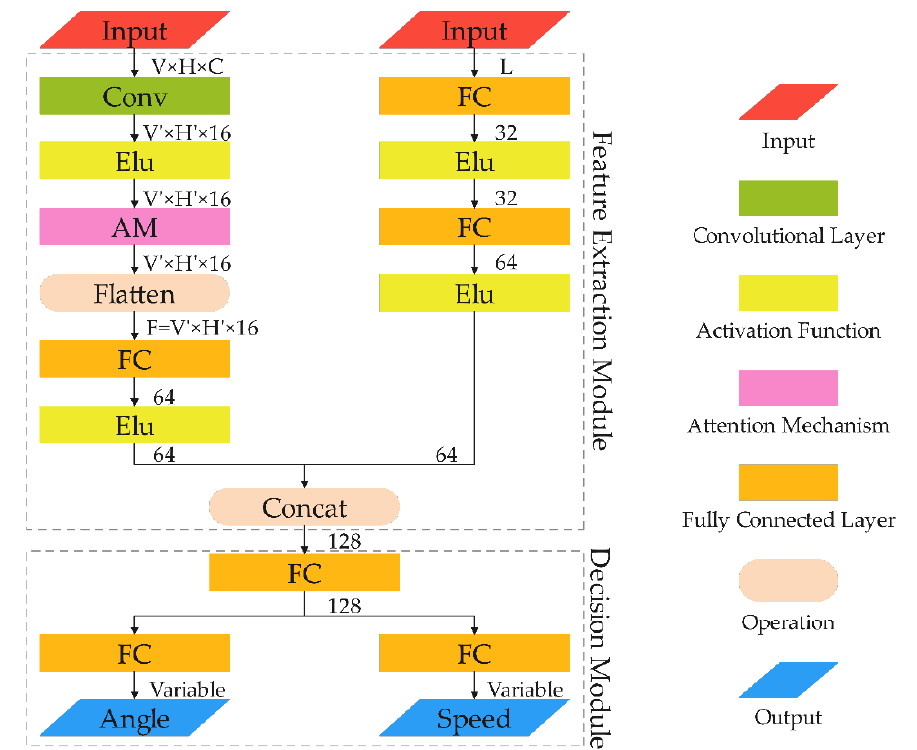
Figure 3. Policy of HDRLM3D.